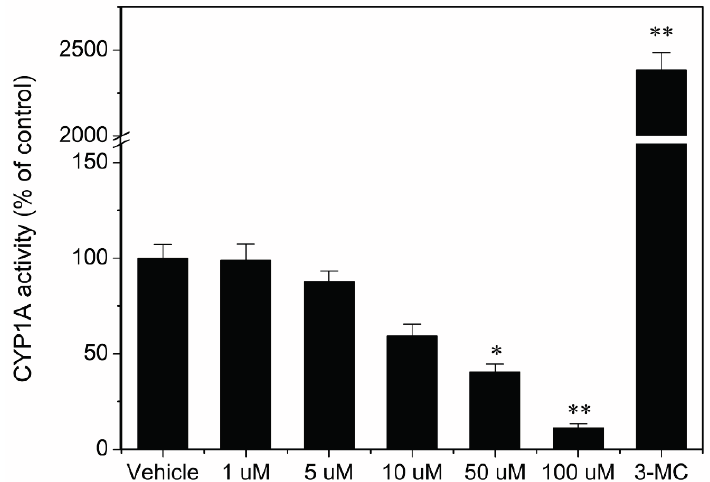
Figure 4. Induction of CYP1A activity in rat hepatocytes by TCAS.